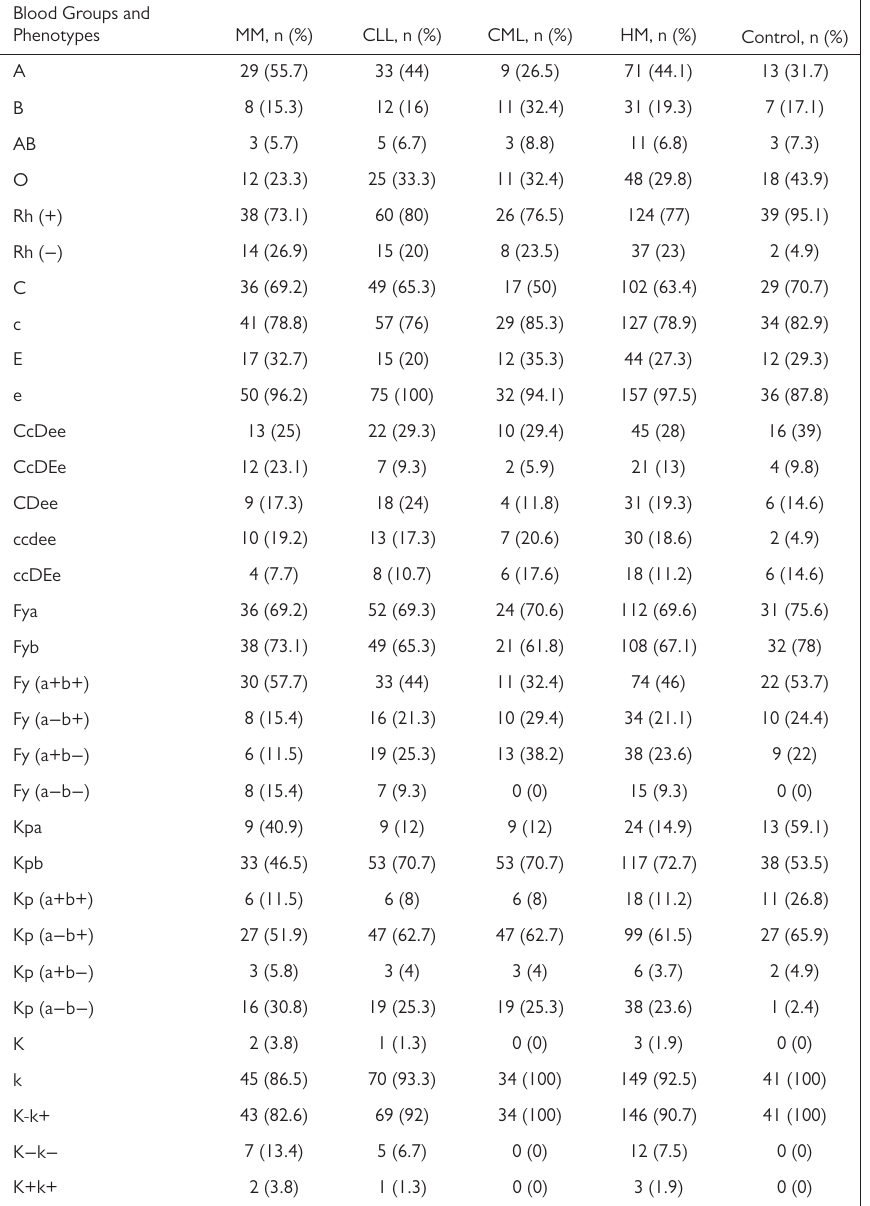
Table 3. Significant Differences Between HM and Control Groups in Terms of ABO, Rh, Kell, Duffy, C, c, E, e Blood Groups and Duffy, Kell, Rh Blood Group Phenotypes